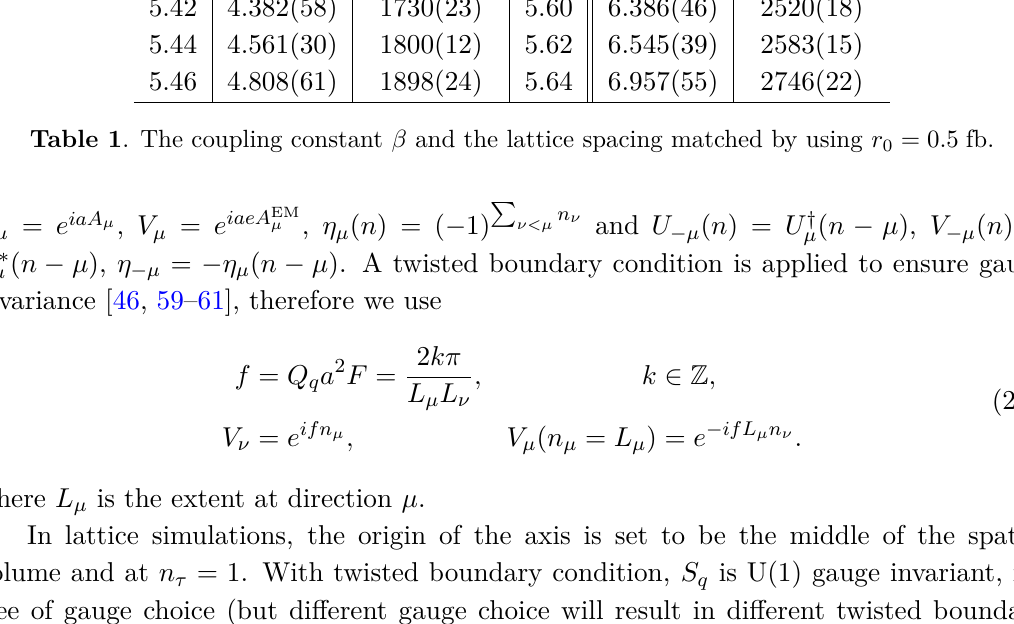
= e iaeA EM µ , η µ